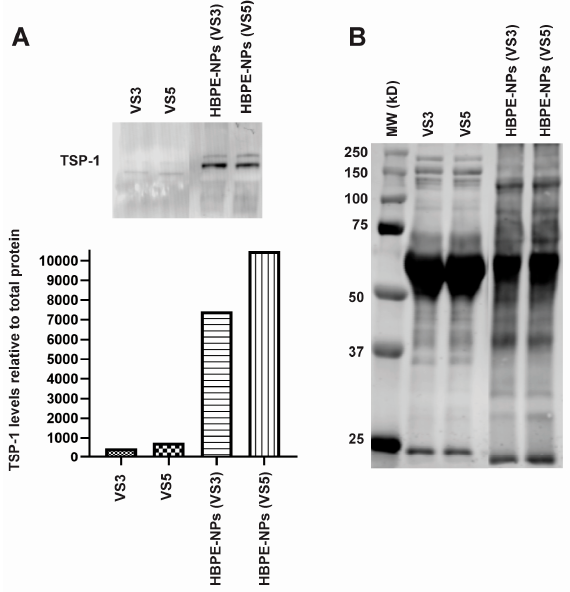
Figure 6. TSP-1 is found in the protein corona formed on HBPE-NPs after treatment with VS5. Proteins absorbed by HBPE-NPs treated with VS3 and VS5 were assessed by SDS-PAGE gels. ( A ) TSP-1 presence in sera alone or on NPs was determined using an anti-TSP-1 antibody (upper panel). The antibody signal was normalized to total protein and quantified using LI-COR Image Studio Lite software (graph, lower panel). ( B ) Total protein per lane was evaluated using REVERT total protein staining. HBPE-NPs were treated with sera at a ratio of 0.1 mg nanoparticle: 20 µg sera. A Precision-Plus Protein Dual Color protein reference ladder was used for molecular weight (MW) comparison. Data shown are representative of two experiments. Raw data is shown in Figure S6. Abbreviations: TSP-1 (thrombospondin-1).